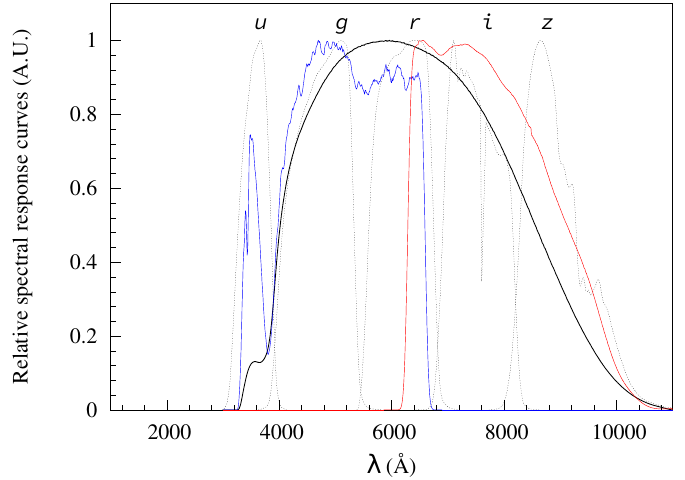
Figure 1. SDSS ugriz (gray dashed curves) and Gaia G (black solid curve), G BP (blue solid curve), and G RP (red solid curve) photometric